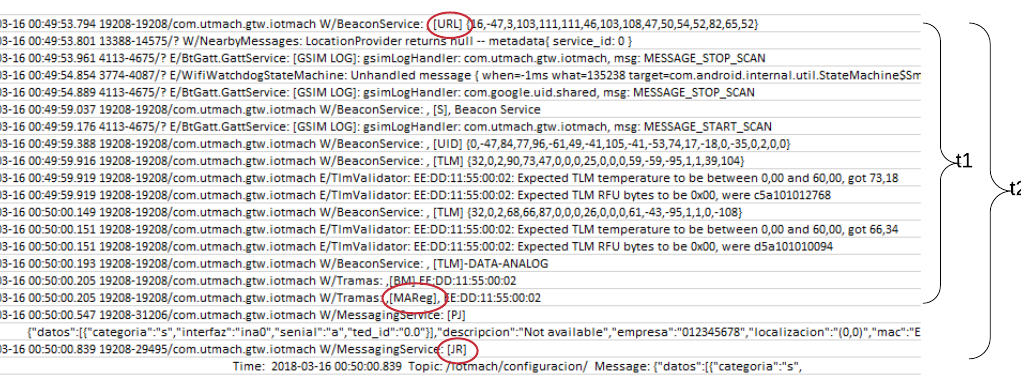
Figure 32. Example of Android log for measuring